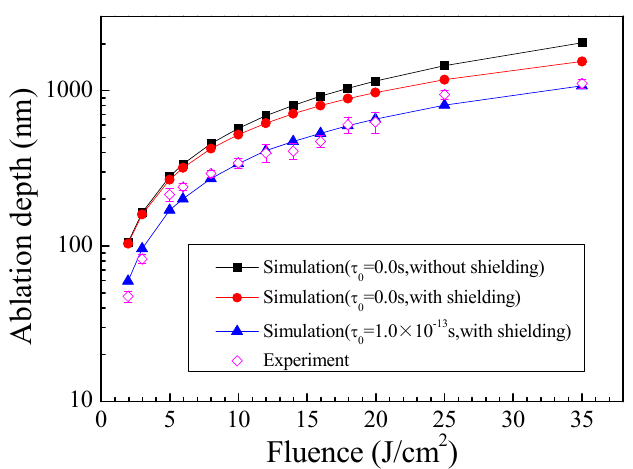
Figure 10. Comparison of simulation results of ablation depth with the experimental results from Reference [58].